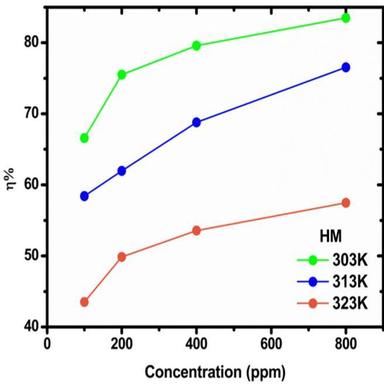
Corrosion rate versus varied concentration (100 ppm, 200 ppm, 400 ppm and 800 ppm of HM) at studied temperatures.